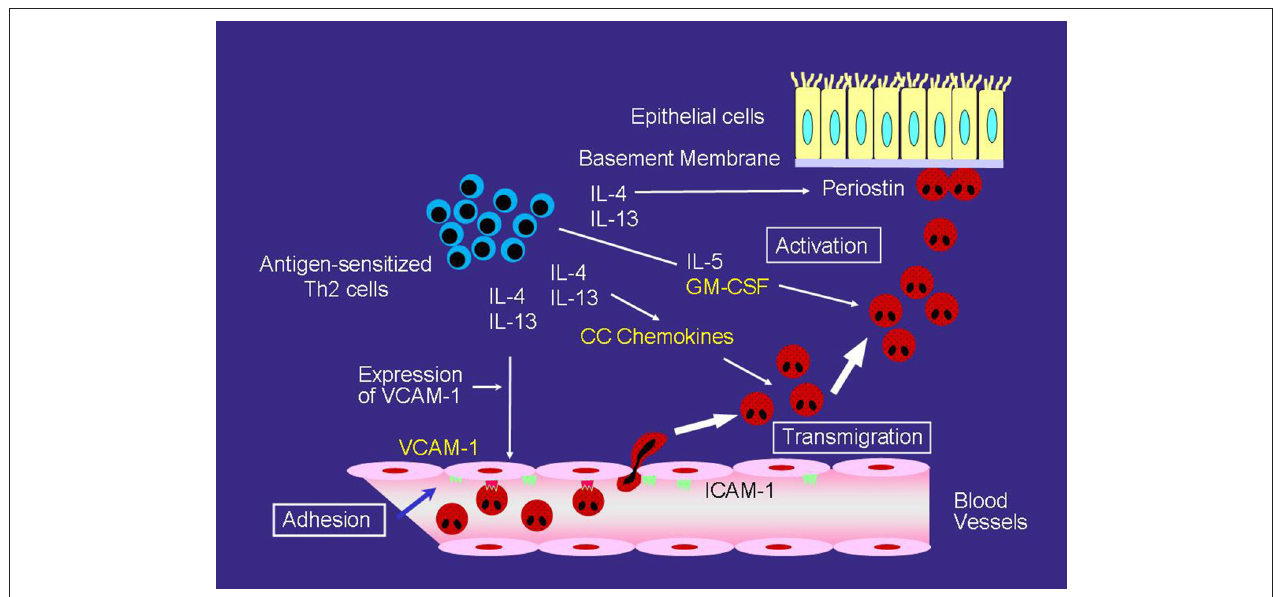
FIGURE 1 | Mechanisms of eosinophilic airway inflammation in bronchial asthma. IL-5 plays an important role in the development of eosinophilic airway inflammation. However, in the absence of IL-5, the Th2 network, which includes a cascade of VCAM-1/CC chemokines/GM-CSF, can maintain eosinophilic infiltration and activation. Yellow text indicates a cascade of VCAM-1/CC